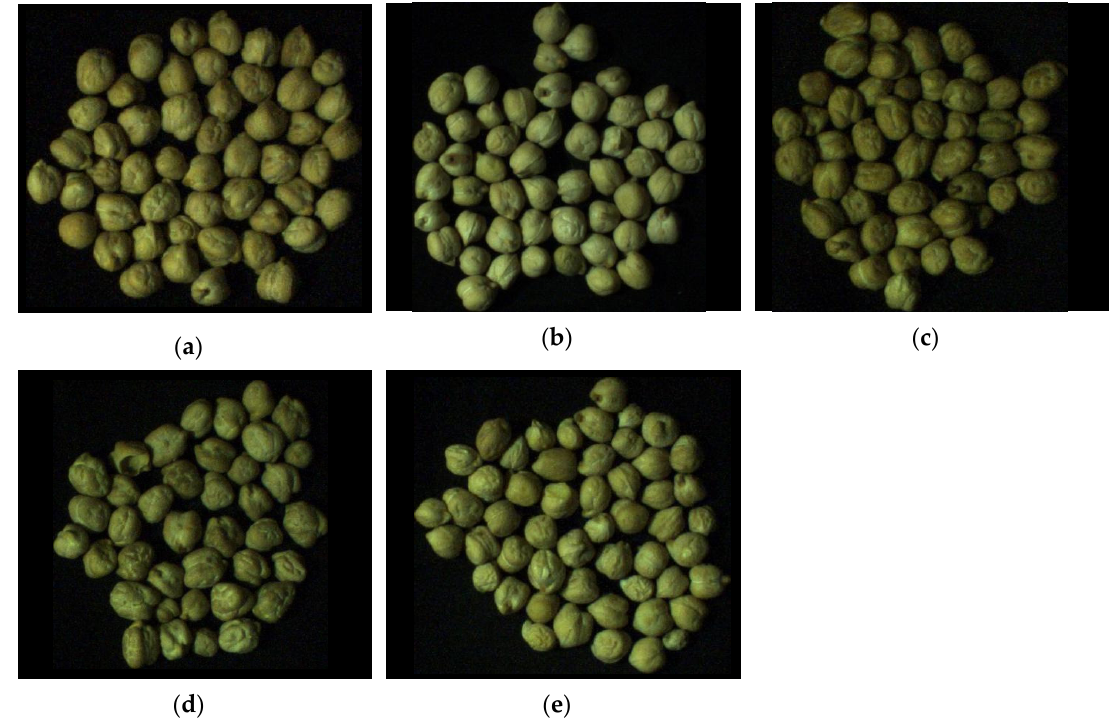
Figure 1. Sample images from each chickpea ( Cicer arietinum L) variety: ( a ) Adel; ( b ) Arman; ( c ) Azad; ( d ) Bevanij; ( e ) Hashem.